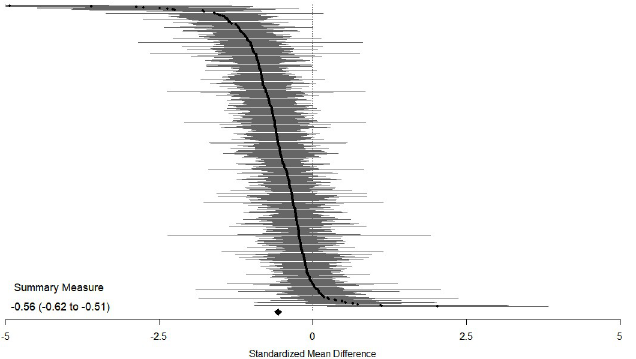
Fig 3. Caterpillar plot of all outcome measures included in the meta-analysis. Efficacy measured as standardized mean difference between medication and placebo for the primary outcome (aggregate measure of mental-health- related symptoms). Standardized mean differences less than 0 favor medication, and those greater than 0 favor placebo. Horizontal lines indicate 95% confidence intervals for each included outcome measure; the horizontal points of the diamond are the limits of the 95% confidence interval of the overall summary measure.